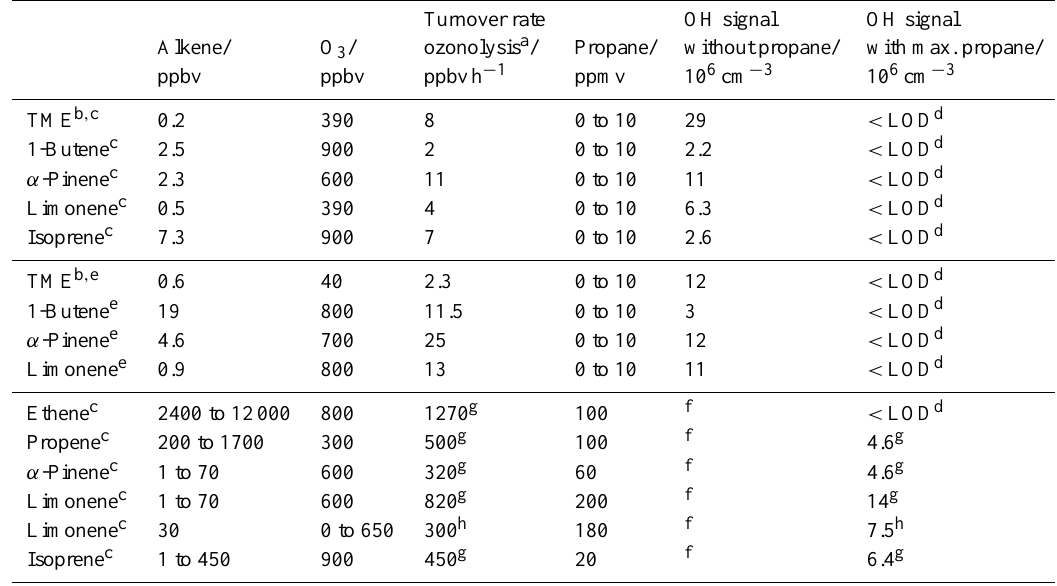
Table 1. Experimental conditions during flow tube ozonolysis experiments in dry synthetic air shown in Figs. 4 and 5. Laser power was around 13mW. Turnover rate OH signal OH signal Alkene/ O 3 / ozonolysis a / Propane/ without propane/ with max. propane/ ppbv ppbv ppbvh − 1 ppmv